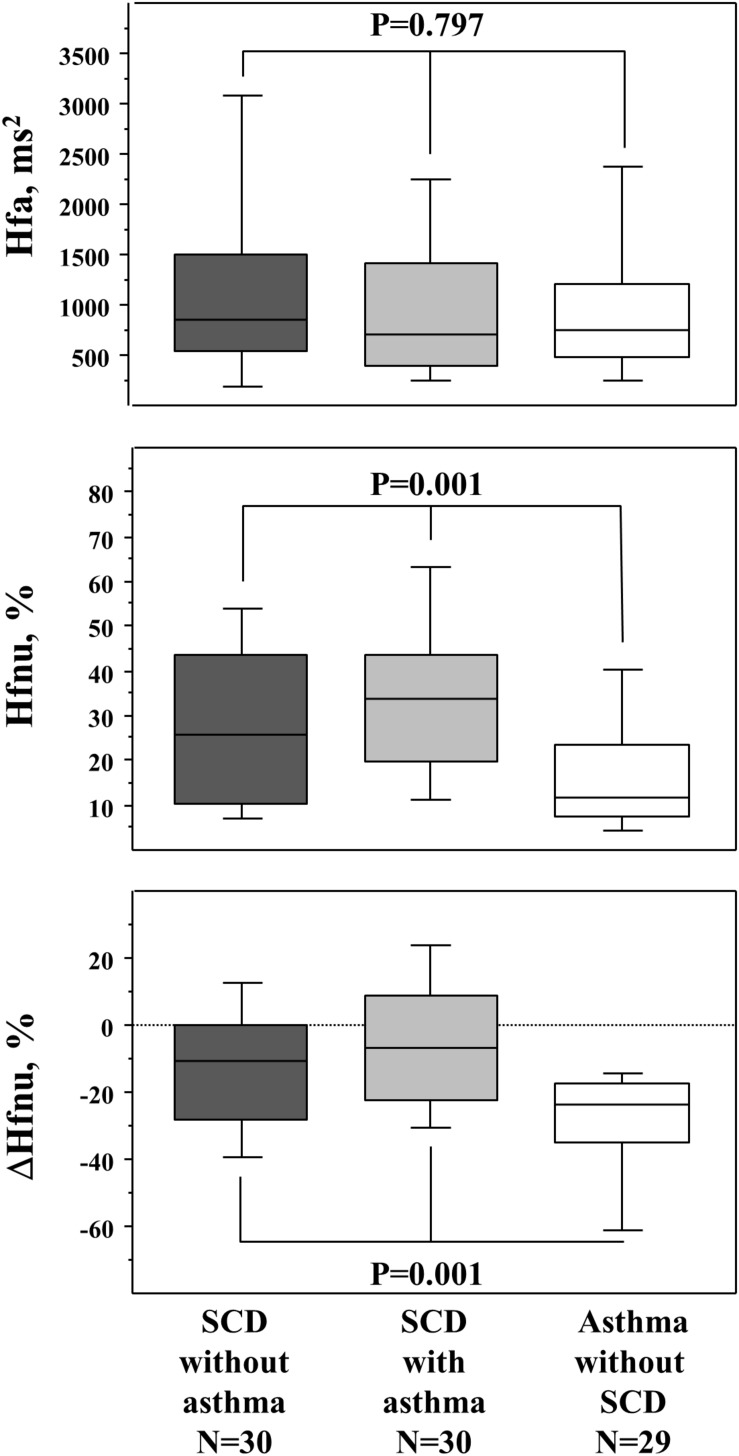
Response to paced ventilation (respiratory sinus arrhythmia evaluation). The upper panel is the HFa (raw values of HF), the middle panel is the normalized HF (Hfnu), and the lower panel is the ΔHFnu (stimulated minus baseline condition). p values are those of the Kruskal–Wallis test between the three groups. The Mann–Whitney U test further demonstrated that the two SCD groups differed from the asthmatic non-SCD group in the middle and lower panels (data not shown). Box and whisker plots show median, 25 and 75th percentiles, and 10 and 90th percentiles.